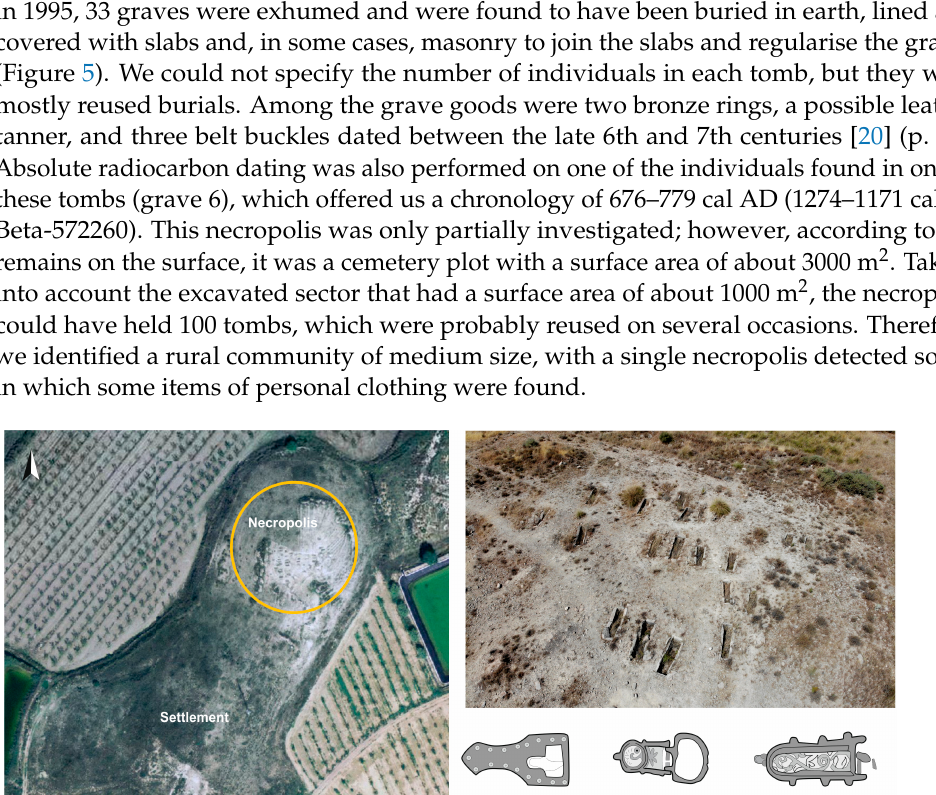
Figure 6. Details of the evidence documented in the recent excavation of LE. The top panel shows a reused burial with three Visigothic individuals (the yellow circle marks the location of the grave that appears in the detail image); the bottom panel shows a room that was part of a larger building, which could have been a domestic space with several rooms (the yellow triangle marks the location of the structure that appears in the detail image).